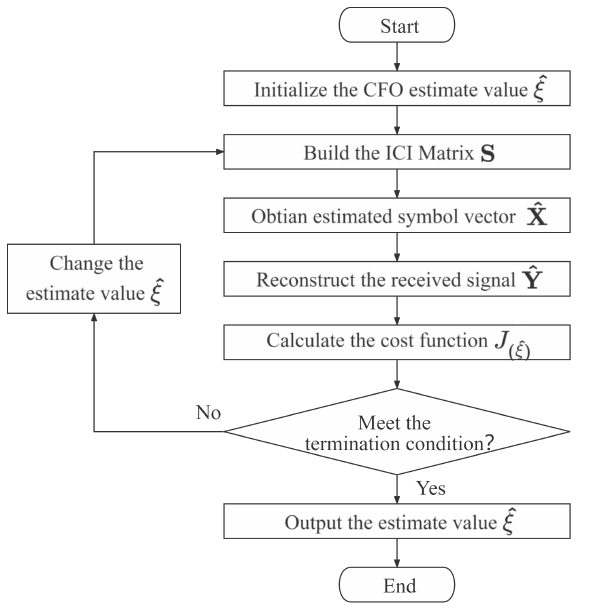
Figure 1. A flowchart that describes the process of the CFO estimation presented in Section